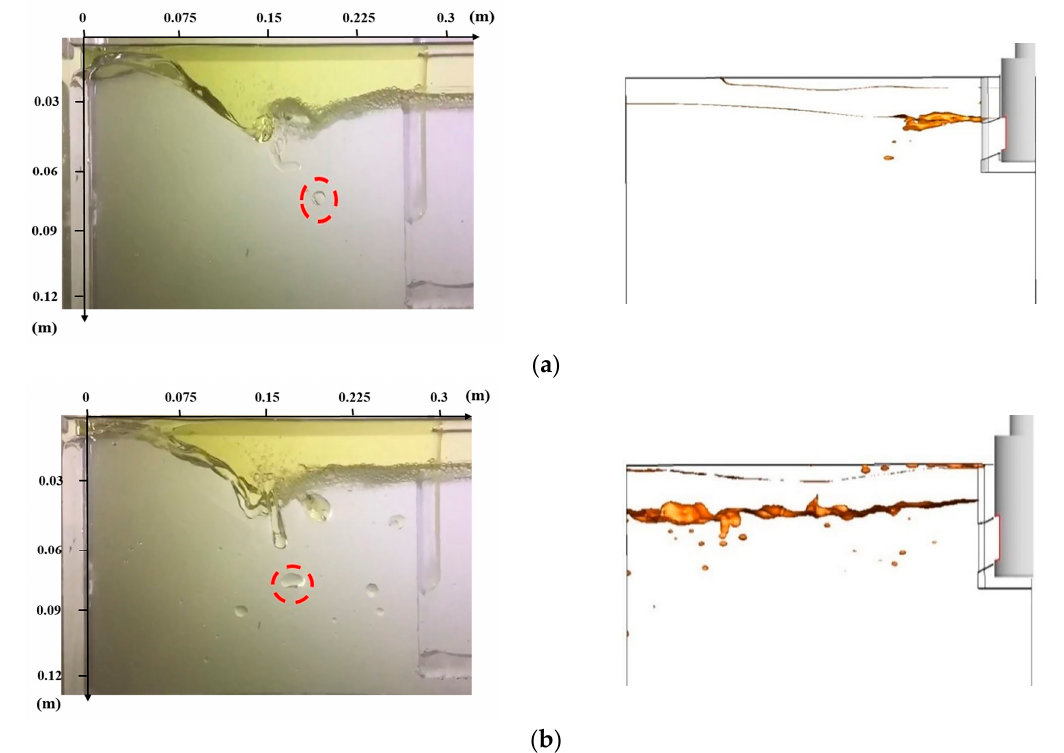
Figure 11. Comparison of water simulation experiments and numerical results: ( a ) t = 5 s; ( b ) t = 10 s.